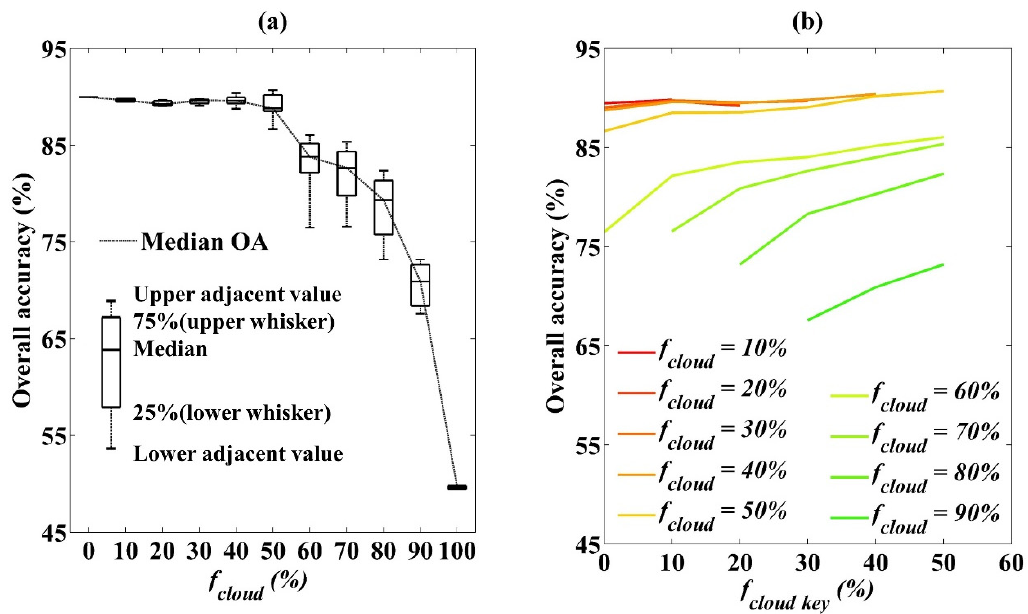
Figure 16. Sensitivity of the PT-DTW method to the percentage of cloud observations in the whole growing period ( a ) and in the key phenological stage ( b ). f cloud and f cloud key denote the fractions of cloud observations in the whole growing period and in the key phenological stage. The black box plot in ( a ) represents the range of OA variation with uneven distributions of cloud observations in key and nonkey stages.